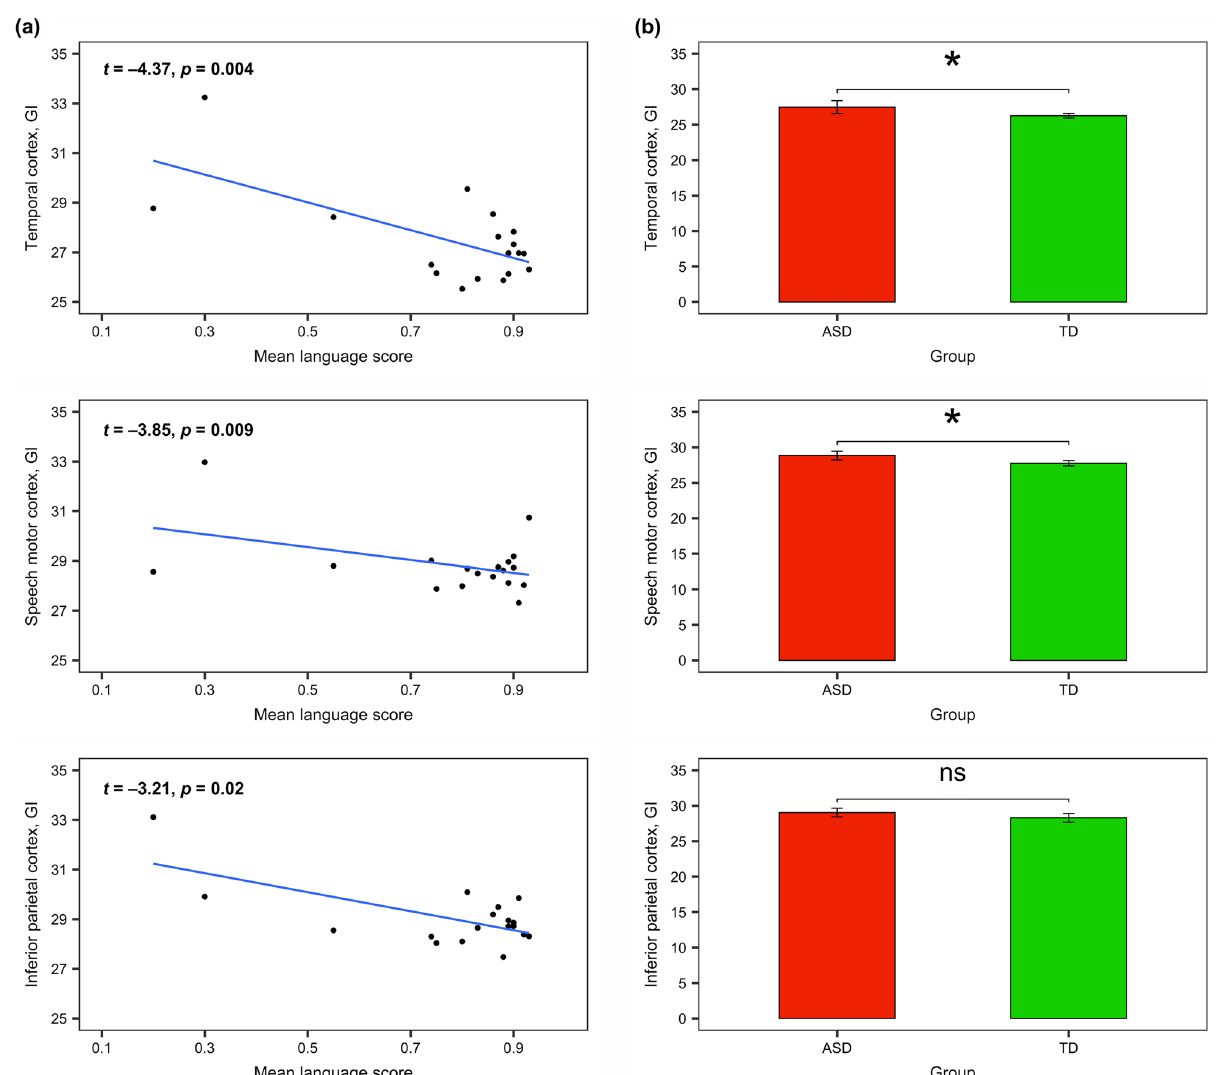
Figure 7. Language-related ROIs analysis (all p -values are Bonferroni-corrected): ( a ) the relationship between Gyrification Index of language-related ROIs and language abilities of children with ASD; ( b ) the